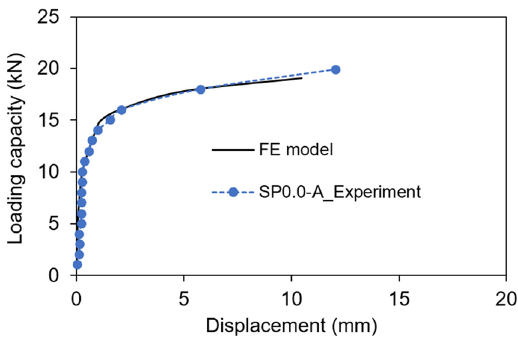
Figure 19: Numerical results for di ff erent reinforcement corrosion degrees.